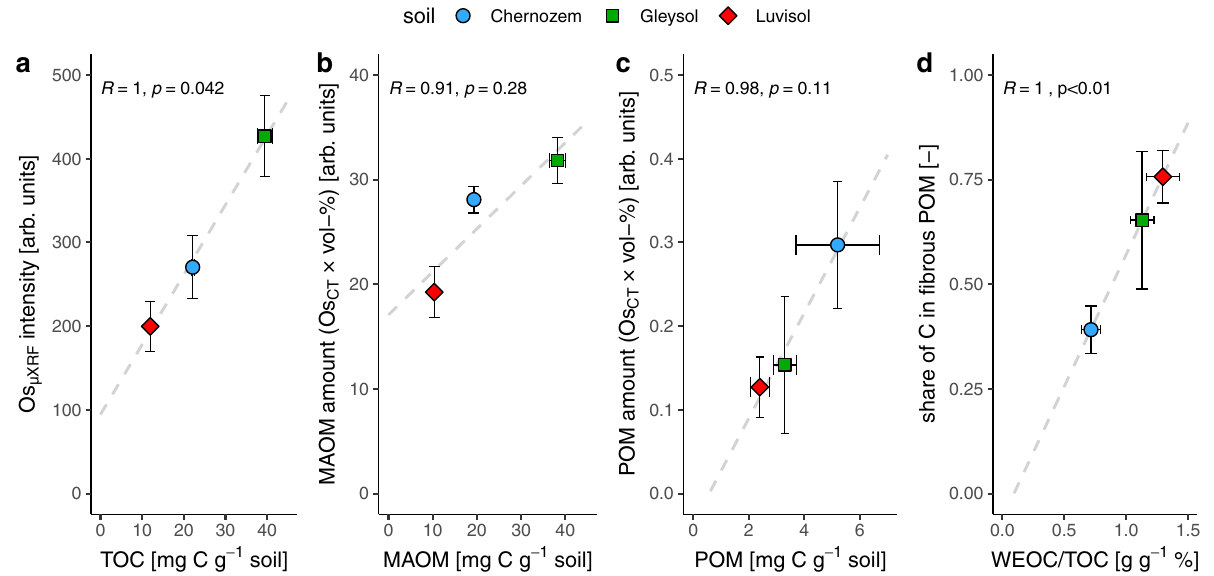
Fig. 2 Comparison of C in organic matter fractions derived from the novel imaging protocol and conventional methods. a Average Os intensity detected with µ XRF (Os XRF ) on soil sections as related to total organic C content (TOC). b Image-derived mount of mineral-associated organic matter (MAOM) derived from the product of average Os intensity of matrix voxels and the volume fraction of matrix voxels over all soil voxels as related to the soils ’ contents of C within MAOM. c Same comparison as in b but for C in particulate organic matter (POM). d Image-derived share of C bound to fi brous POM over C bound to total POM as related to the fraction of water-extractable organic C (WEOC/TOC) in soil aggregates. Arbitrary units in Os intensity arise from normalization with different references materials. Error bars correspond to two standard errors in each direction with n = 8 for image-derived data ( y axis) and n = 3 for conventional analyses ( x axis). All linear regressions are based on n =